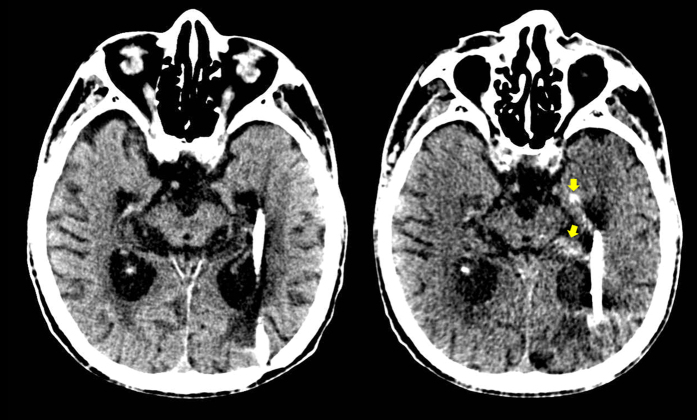
Confirmation of the direct CSF communication between the lateral ventricles and the ambient cistern by shuntography in patients with iNPH with a suspected shunt malfunction.Contrast medium (yellow arrow head) was observed not only in the left inferior horn of the lateral ventricles but also in the left ambient cistern on CT scan immediately after shuntography (right), compared to that before shuntography (left).